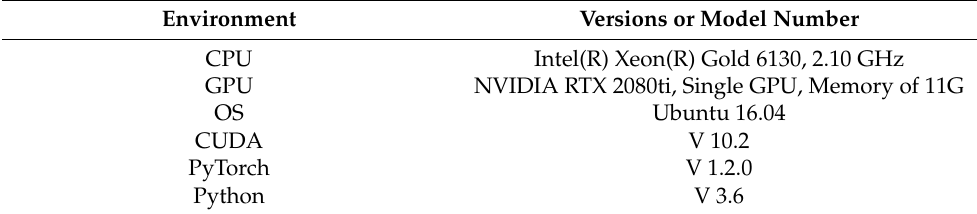
Table 3. The environment for the experiments.